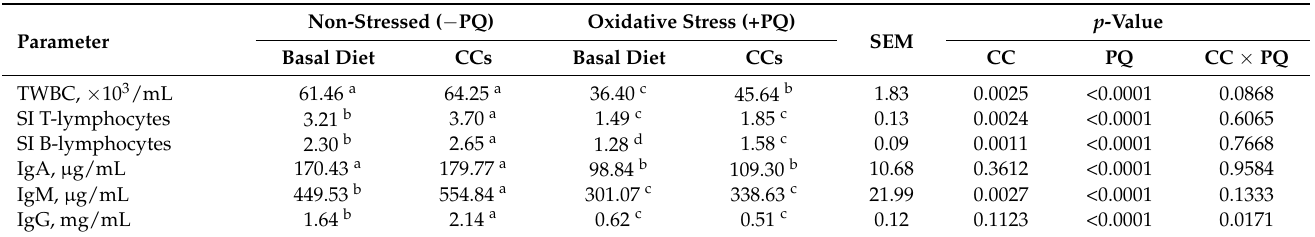
Table 6. Immunological response of layers subjected to paraquat-induced oxidative stress (PQ) and dietary Citrullus colocynthis seed supplementation